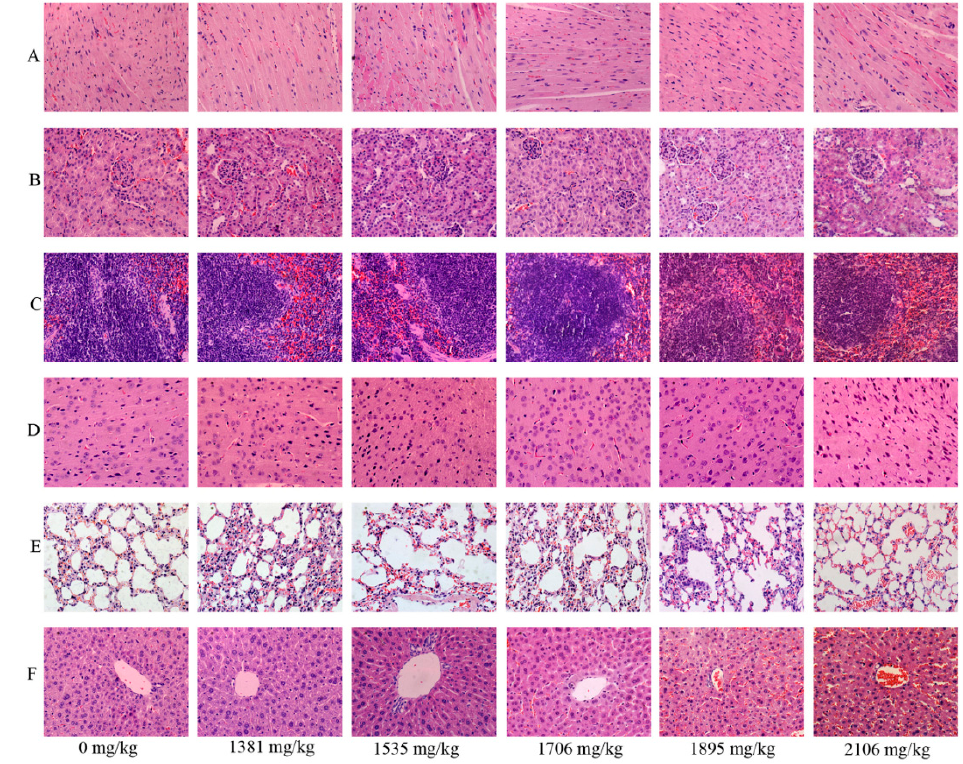
Figure 4. Representative histological pictures of heart ( A ), kidney ( B ), spleen ( C ), brain ( D ), lung ( E ) and liver ( F ) staining with H&E in the acute toxicity study (magnification 400×). 2.5. Effects of SalB-Rg1 on the Organ Structure with a Single Dose in Acute Toxicity